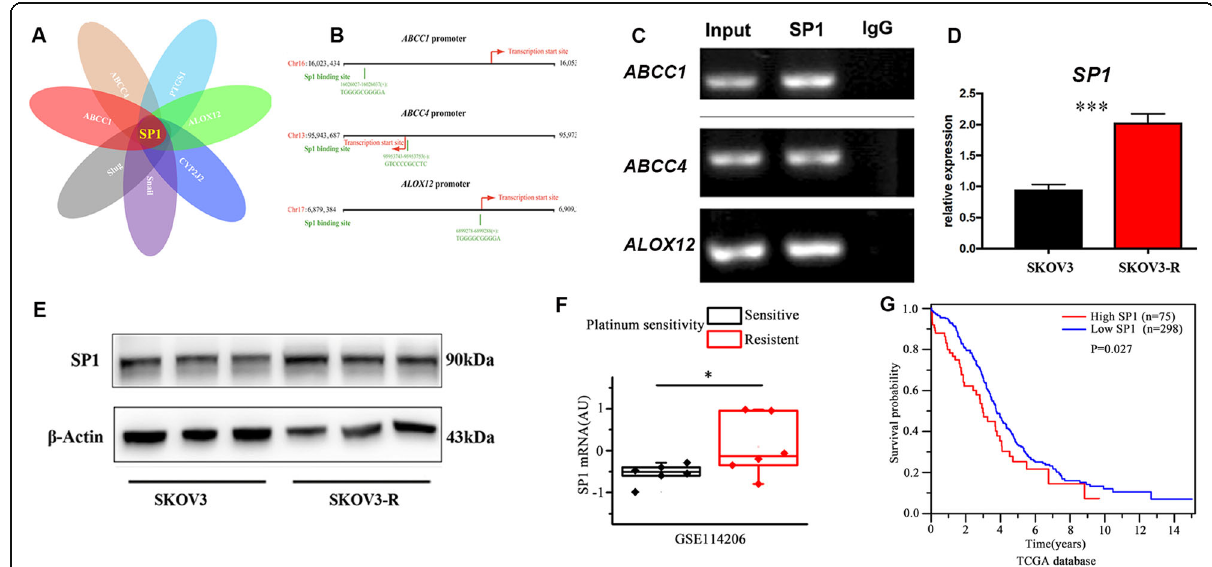
Fig. 2 Identification of SP1 as the mutual transcription factor of MRPs and 12LOX. a Bioinformatic analysis of transcription factors of MRP1 , MRP4 , Snail , Slug , 12LOX , COX1 , and CYP2J2 . b SP1 binding sequences in the promoters of MRP1 ( ABCC1 ), MRP4 ( ABCC4 ), and 12LOX ( ALOX12 ). c ChIP assay of SP1 binding on the promoters of MRP1 ( ABCC1 ), MRP4 ( ABCC4 ), and 12LOX ( ALOX12 ). d, e The mRNA ( d ) and protein ( e ) expression levels of SP1 in SKOV3 and SKOV3-R cells. Data in ( d ) are expressed as mean ± SEM of 4 independent experiments. *** P < 0.001. f The unpaired Student ’